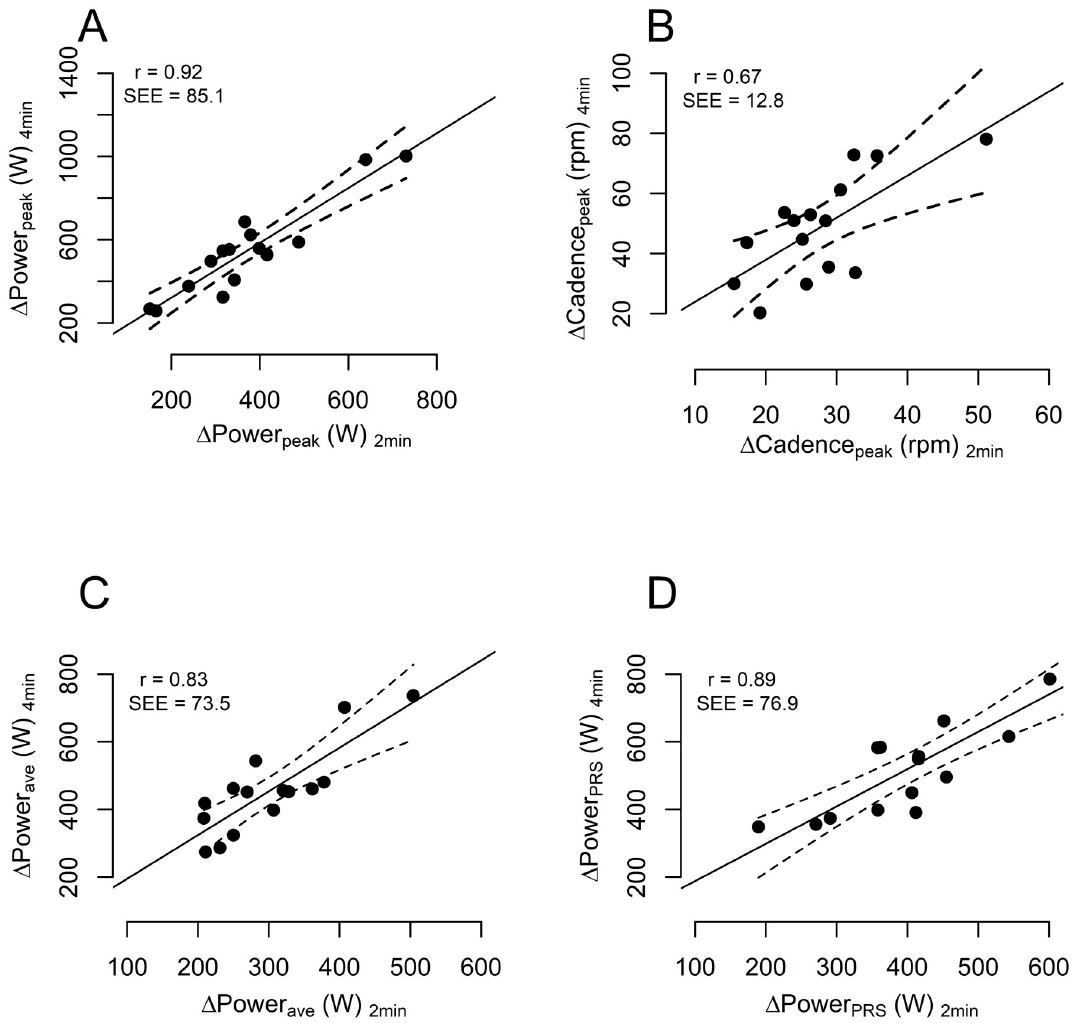
Fig 4. Relationships between 2-min and 4-min CWR tests for changes in ( Δ ) mechanical variables obtained in the sprints. Correlation and standard error of the estimates (SEE) between the CWR tests are displayed on the top left corner of each graph. Dotted lines indicate 95% CIs. Moderate to very strong relationships were observed between mechanical variables obtained during the 2- and 4-min CWR tests.